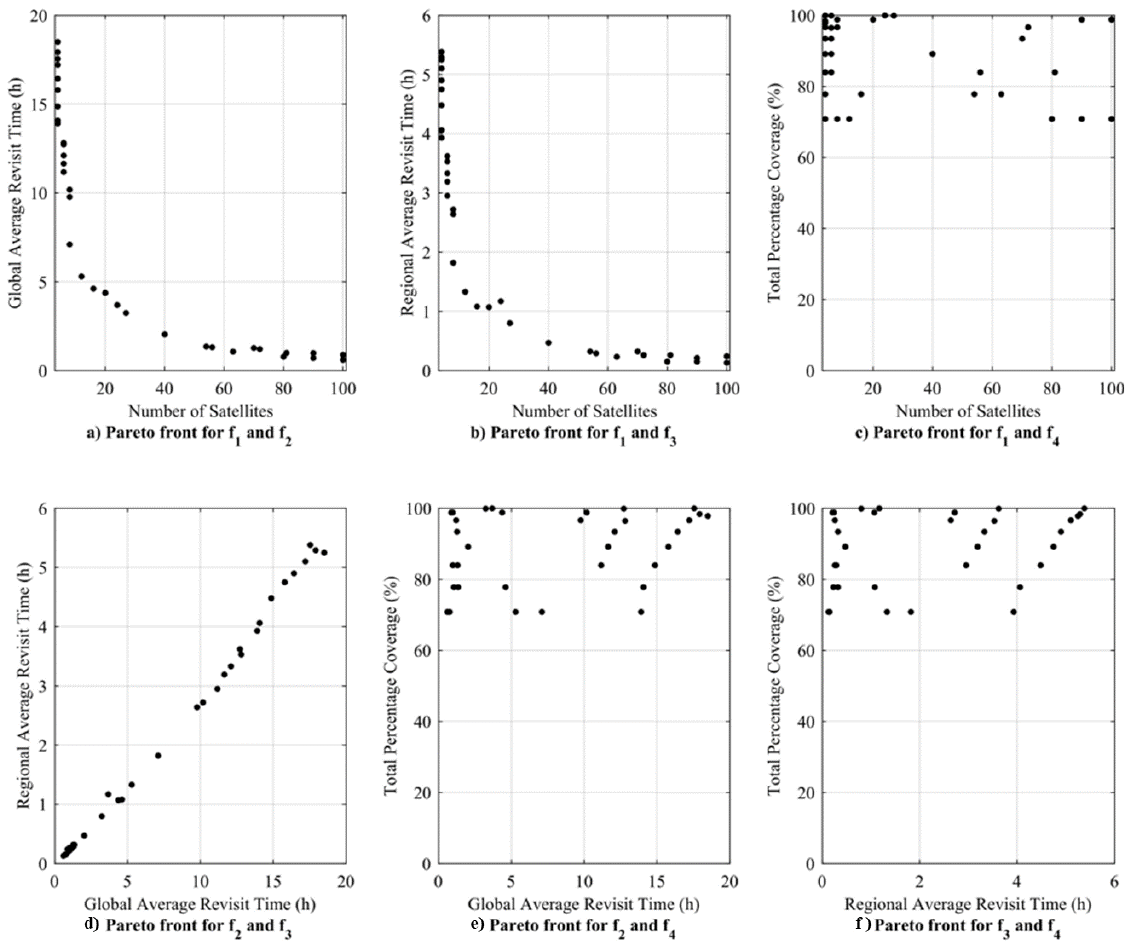
Figure 6. Plot of Pareto front for multi-mission simulation case.